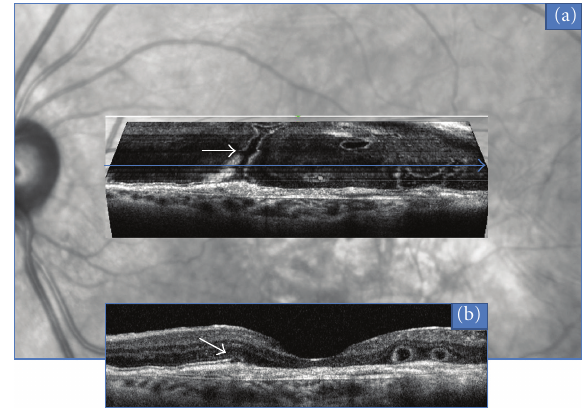
Figure 2: Tubular (arrows) pattern of ORT located above a fibro- vascular scar, observed with “en face” OCT (a). Corresponding B- scan OCT (b).